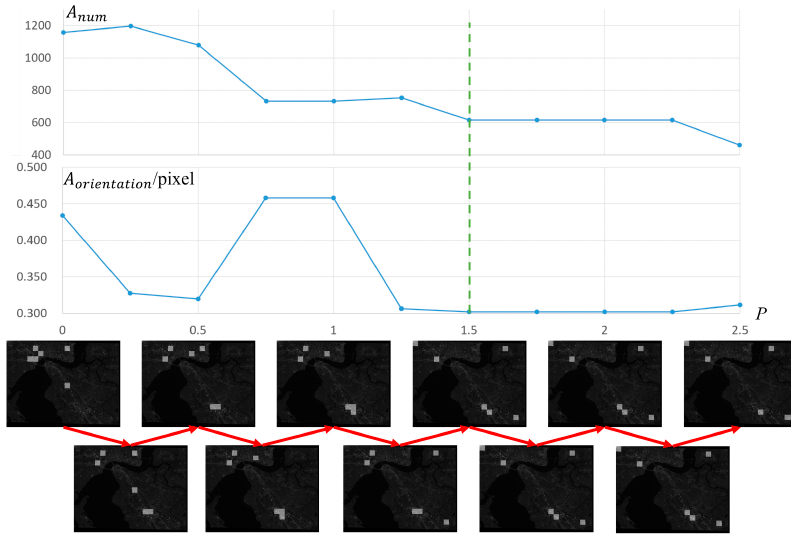
Figure 5. Analysis of 𝑃 .